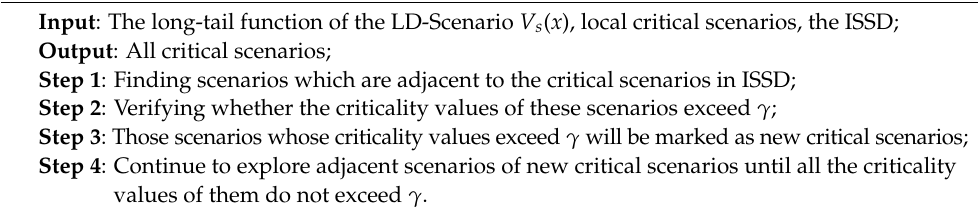
Algorithm 3 Algorithm of flood